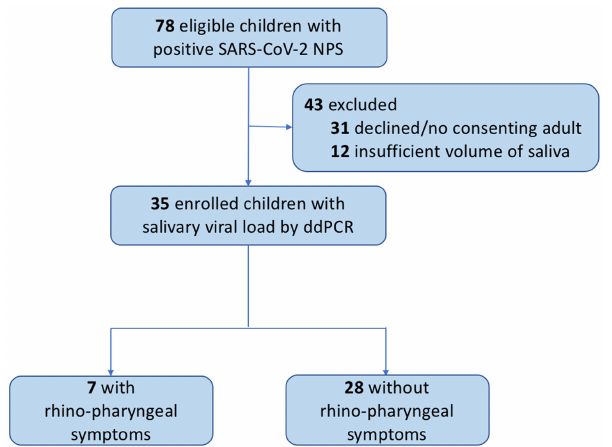
Figure 1. Study flowchart of children and adolescents enrolled in the study. Table 1. Demographic and clinical characteristics of the enrolled